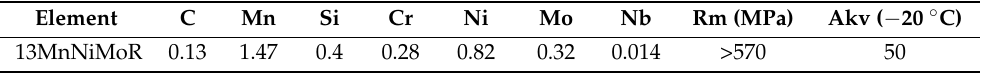
Table 1. The main composition of base metal (mass fraction %) and mechanical properties. Element